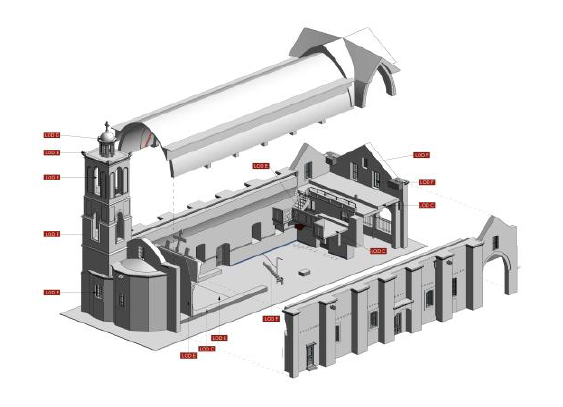
Figure 18. Identification of LODs for each architectural component